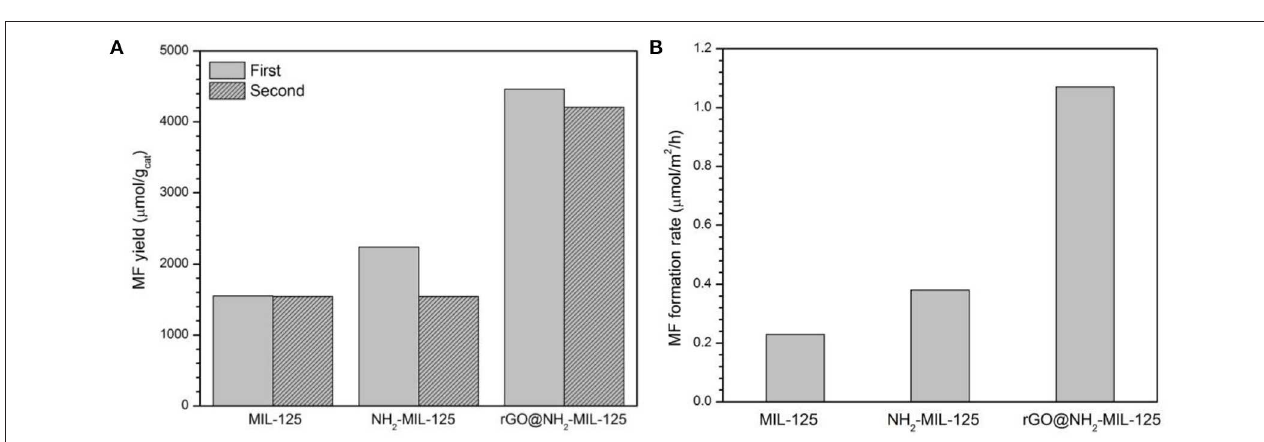
FIGURE 8 | MF yield in units of µ mol · g − 1 cat (A) and in units of µ mol · m − 2 · h − 1 (B) with various catalysts for CO 2 photoreduction in CH 3 OH.